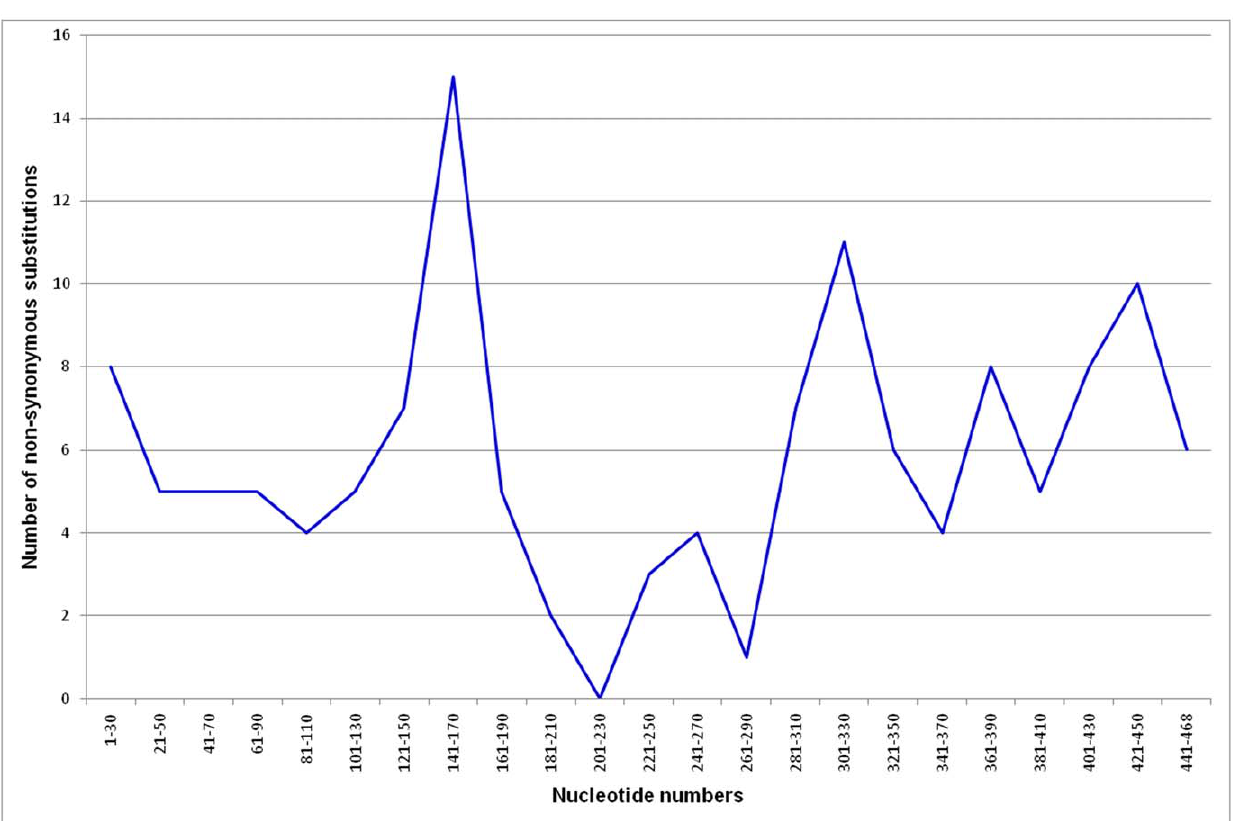
Figure 6. Distribution of missense mutations over the coding sequences of Teleostei fishes. The ancestral sequence of Tetrapoda and Teleostei was used as a reference. The sum of nonsynonymous substitutions was calculated for each 30 nucleotides.